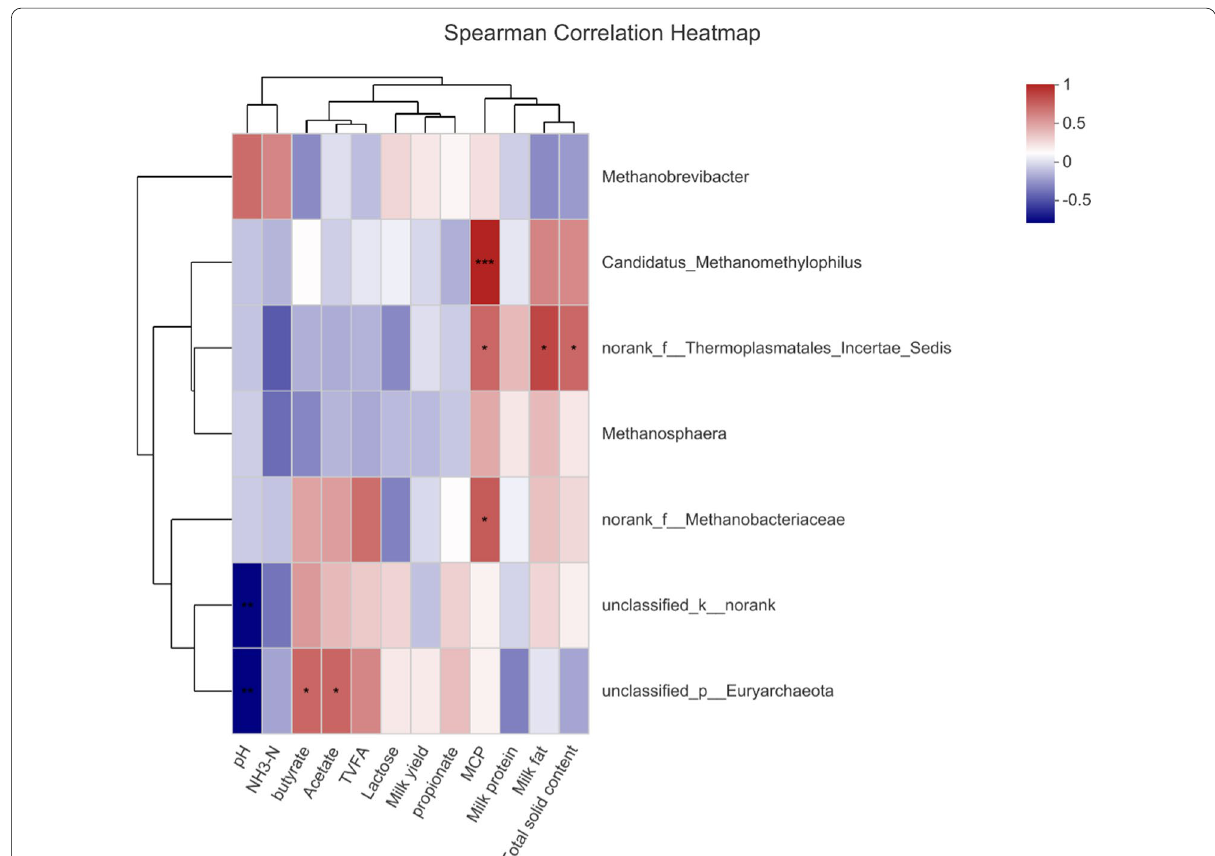
Fig. 4 Correlation of archaeal genera with pH, VFA, milk composition, milk yield, NH 3 –N and